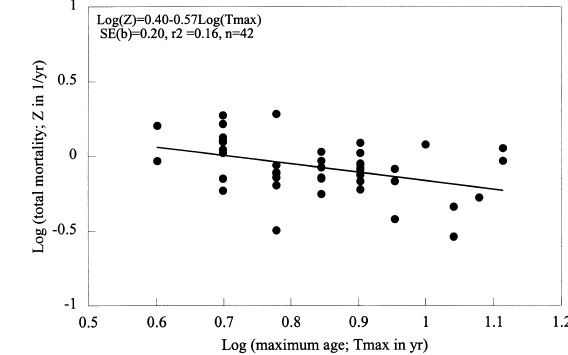
Fig. 9. Relationship between maximum age and the von Berta- lanffy K parameter for a variety of fish stocks in Hellenic waters.